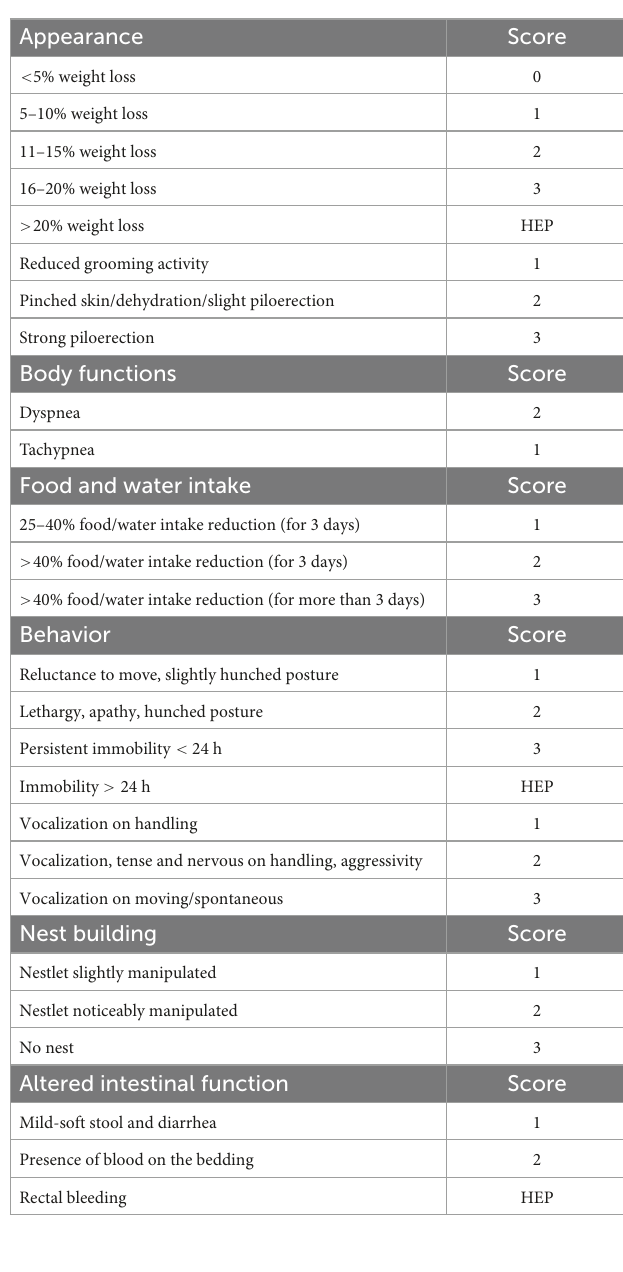
TABLE 1 Scoring system for indicators of pain and distress in